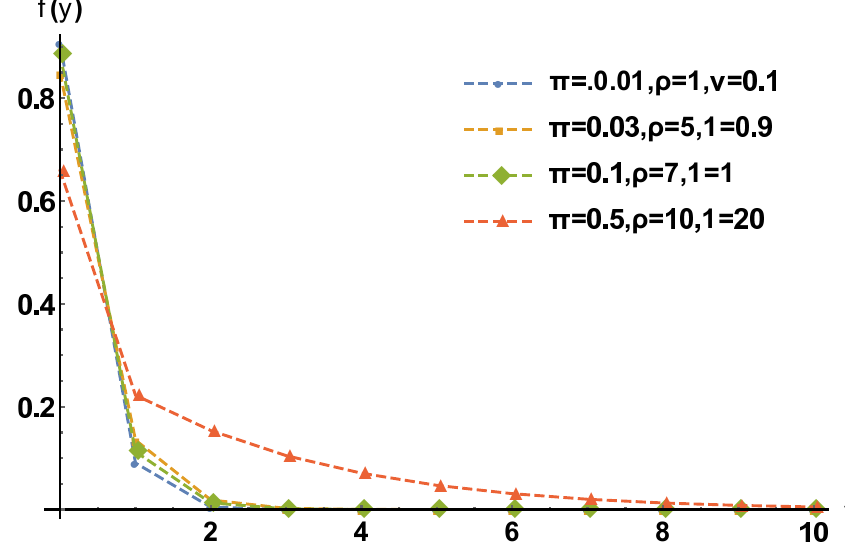
Figure 4 – Plots of probability mass functions of ZIAHPD for different values of π , ρ and ν